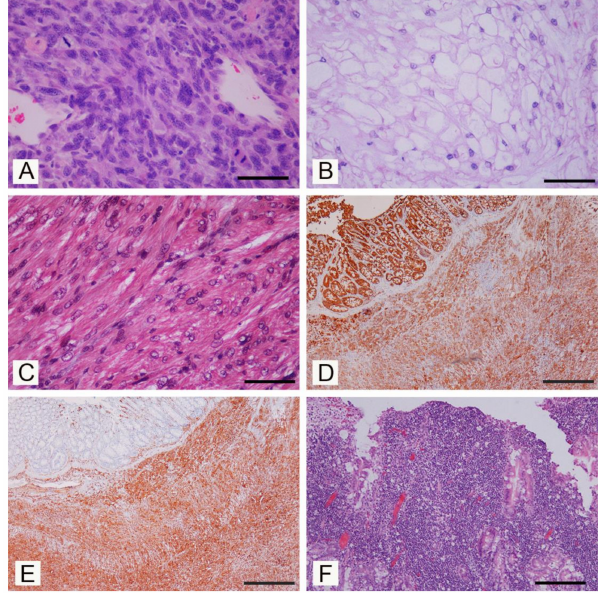
Figure 2. Neoplasia in pet degus ( Octogon degus ), histopathological aspects. ( A ) Fibrosarcoma, bundles of spindle cells with anisocytosis and anisokaryosis, nuclear atypia, and several mitoses (H-E; Bar = 150 µ m). ( B ) Chordoma, characteristic physaliferous cells with vacuolated cytoplasm and round, eccentric nuclei (H-E; Bar = 150 µ m). ( C ) Leiomyosarcoma of the urinary bladder. Bundles of neoplastic spindle smooth muscle cells with cytoplasm stained red (Trichrome Goldner stain; Bar = 150 µ m). ( D ) Mesenteric mesothelioma. Neoplastic cells show marked immunoreactivity for pancytokeratin. (Immunoperoxidase stain, hematoxylin counterstain; Bar = 1000 µ m). ( E ) Mesenteric mesothelioma. Neoplastic cells were also immunorecative for vimentin. (Immunoperoxidase stain, hematoxylin counterstain; Bar = 1000 µ m). ( F ) Intestinal lymphoma, dense infiltrations of lymphoid cells changing the normal architecture of the intestine wall (H-E; Bar = 300 µ